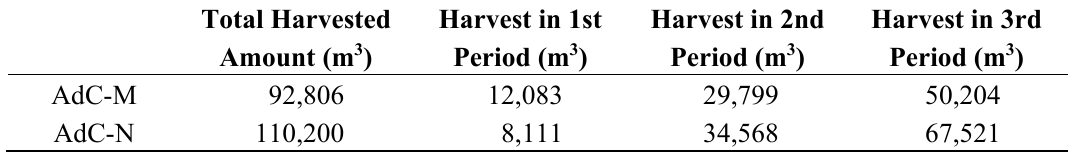
Table 5. The harvest schedule for AdC-M and AdC-N variants for 1.00 × 10 −4 gap